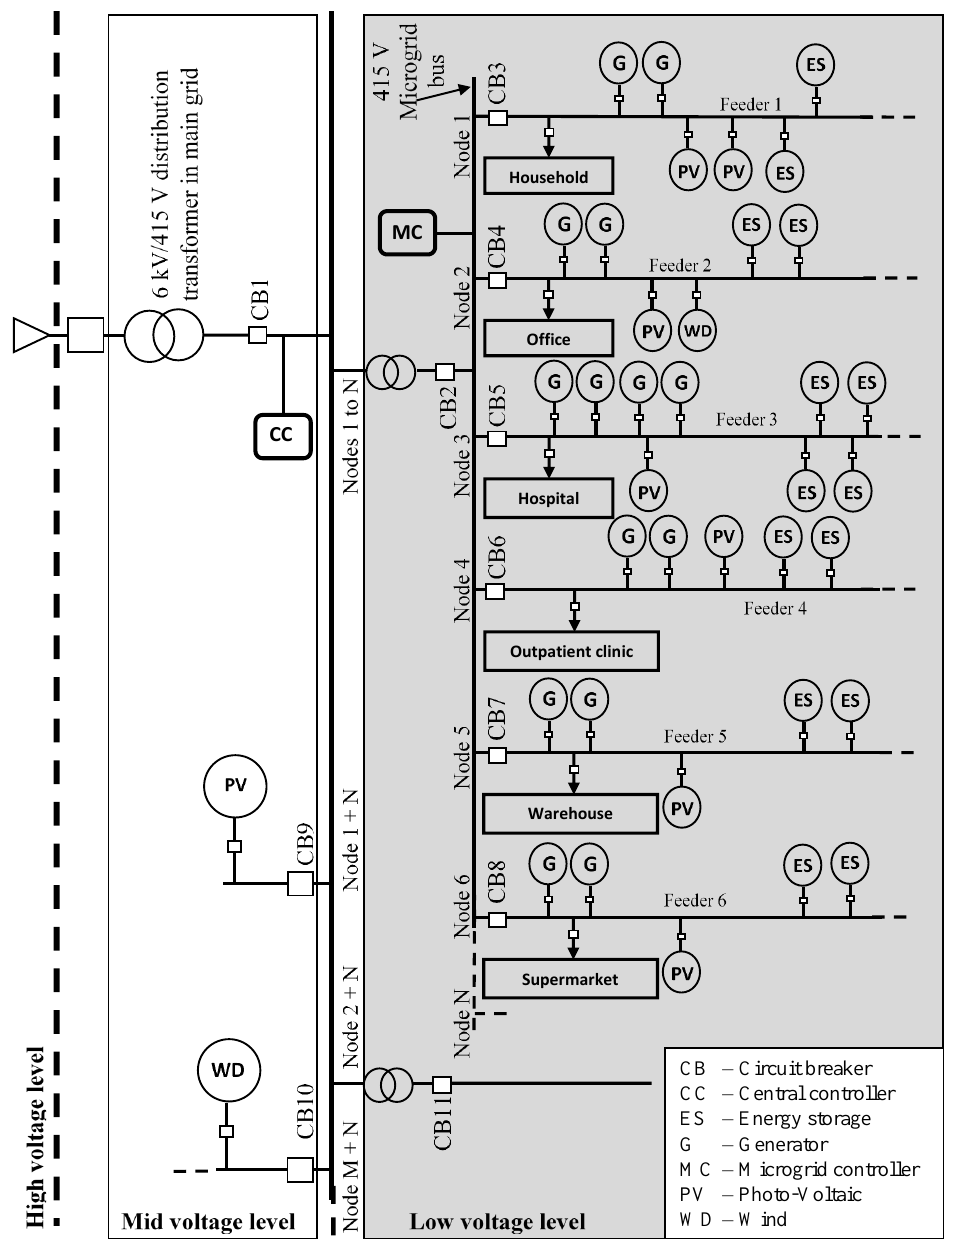
Figure 1. A microgrid configuration, adapted and modified from Liang and Zhuang